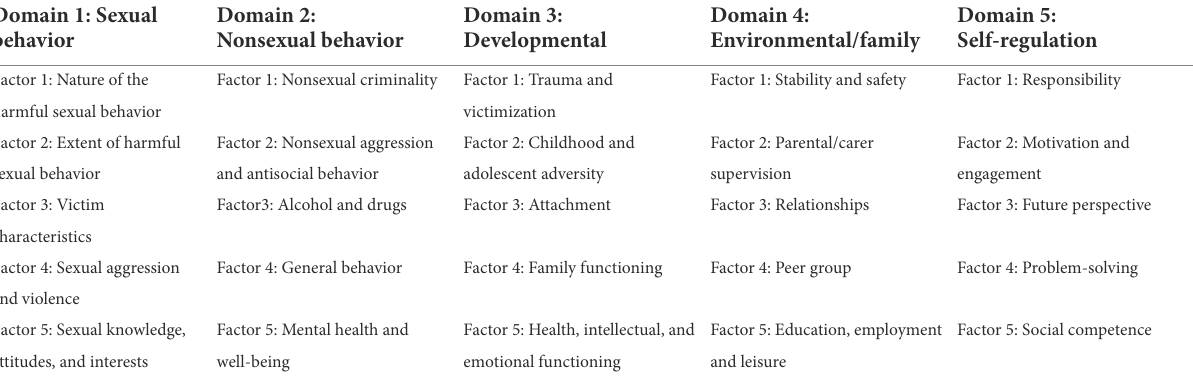
TABLE 1 An overview of the AIM3 assessment model’s domains and